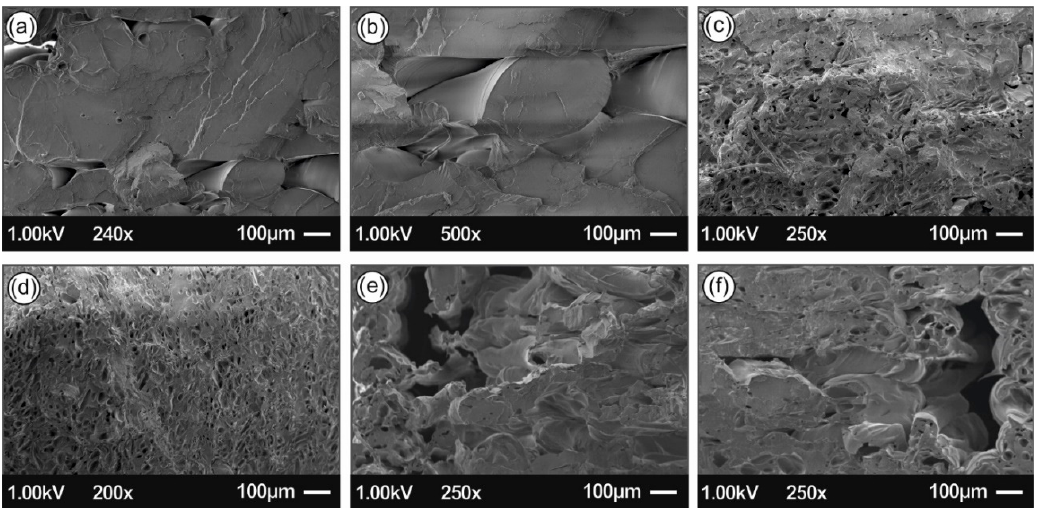
Figure 13. SEM images of the tensile test fractured areas ( a , b ) Neat PLA, ( c ) PLA/Ag/PEG rec-01 specimen, ( d ) PLA/Ag/PEG rec-02 specimen, ( e ) PLA/Ag/PVP rec-03 specimen, and ( f ) PLA/Ag/PVP rec-04 specimen.